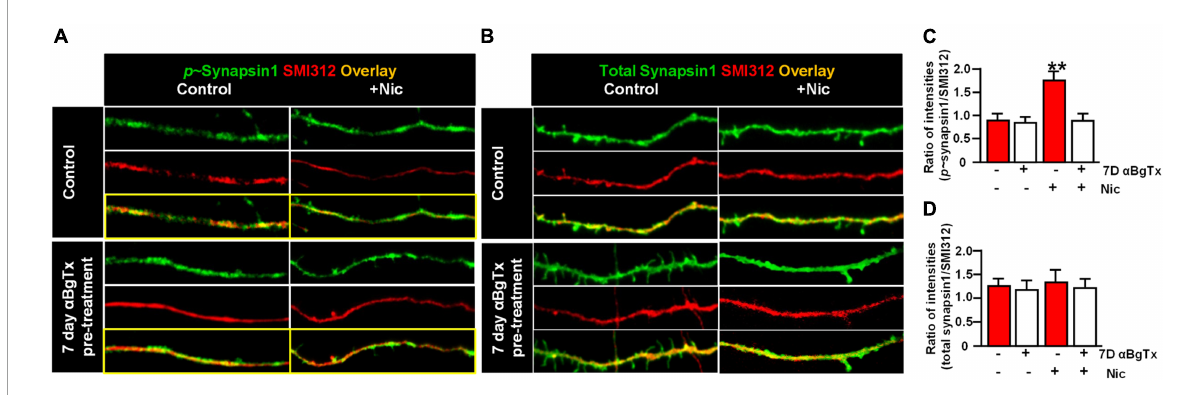
FIGURE3 α 7* nAChRs-mediate nicotine-induced phosphorylation of Synapsin1 along ventral hippocampal axons. Ventral hippocampi were obtained from individual α 7+/+ pups and plated as thinned micro-slices to optimize axon outgrowth as described in detail in Figure 1 legend and in Section “Materials and methods.” A subset of these cultures was treated for 7-days with α BgTx (100 nM). Following acute exposure to nicotine (1 µ M, 1 min), all samples were fixed, permeabilized, and labeled with antibodies recognizing phospho-Synapsin1 or total Synapsin1, and axonal neurofilaments using a “pan axonal” marker: SMI312. (A) Representative micrographs of vHipp axons (SMI312, red) from α 7+/+ mice: no treatment control (top) vs. vhipp axons from α 7+/+ mice following a 7-day, in vitro exposure to 100 nM α BgTx (bottom). These cultures were than subject to incubation under either control or + acute nicotine (1 min) treatment. After 5 min cultures were fixed, permeabilized and the distribution of phospho-synapsin1 was visualized (green) along vHipp axons; control (left) vs. 1 min after nicotine (right, scale bar: 10 µ m). Note that the nicotine elicited increases in phosphorylated Synapsin1 seen along the α 7+/+ control vHipp axons (top, right) was not detected in 7 D, chronic α BgTx treated conditions (right bottom). (B) Representative micrographs of vHipp axons (SMI312, red) from α 7+/+ control (top) or α 7+/+ following a 7-day exposure of α BgTx (bottom) prior to acute control vs. nicotine treatment. After fixation and permeabilization, the distribution of total Synapsin1 (green) was visualized along vHipp axons (SMI 312; red); Control (left) vs. 1 min treatment with acute nicotine (right, scale bar: 10 µ m). There are no differences in total Synapsin1 or in SMI 312 labeling with (left, bottom) or without (left, top) 7-day pre-treatment with α BgTx. Nicotine did not increase total Synapsin1 along α 7+/+ control vHipp axons (top, right) and the 7 D, chronic α BgTx treated vHipp axons (bottom, right). (C) Pooled and quantified data from experiments as shown in (A) . Twenty axon segments per condition were assayed in three separate experiments (four conditions; total n = 80; 3). Phospho-Synapsin1 immunofluorescent intensities along vHipp axons were quantified as a ratio of p-Synapsin1/SMI312 per 100 µ m axon length. With no pre-treatment, the p-Synapsin1/SMI 312 ratio was 0.88 ± 0.12 before nicotine exposure and ∼ 2-fold higher after acute nicotine application (1.74 ± 0.18). In contrast, the 7-day pretreatment with α BgTx, a specific α 7* nAChRs antagonist, blocked nicotine induced phosphorylation of Synapsin1 (0.85 ± 0.09 before vs. 0.90 ± 0.16 after nicotine) without altering the baseline ratios. All data were first tested for distribution normality by the test(s) listed in Table 1 prior to statistical analysis. Data represent the mean ± SEM, ** p < 0.01, One-Way ANOVA Post Hoc Tests. See Table 1 for all n values and statistical tests. (D) Pooled and quantified data from experiments as shown in (B) ( n = 80, 3). Total Synapsin1 immunofluorescent intensities along vHipp axons were quantified as ratio of total Synapsin1/SMI312 per 100 µ m axon. The ratio of total Synapsin1 to SMI312 was unaffected by acute nicotine exposure whether under control conditions (1.28 ± 0.16 before vs. 1.39 ± 0.18 after nicotine application) or if vHipp axons were pre-treated with a 7-day exposure to 100 nM α BgTx (1.21 ± 0.18 before vs. 1.26 ± 0.18 after nicotine application). All data were first tested for distribution normality by the test(s) listed in Table 1 prior to statistical analysis. Data represent the mean ± SEM, p > 0.05, One-Way ANOVA Post Hoc Tests. See Table 1 and (D) panel specific data for all n values and statistical